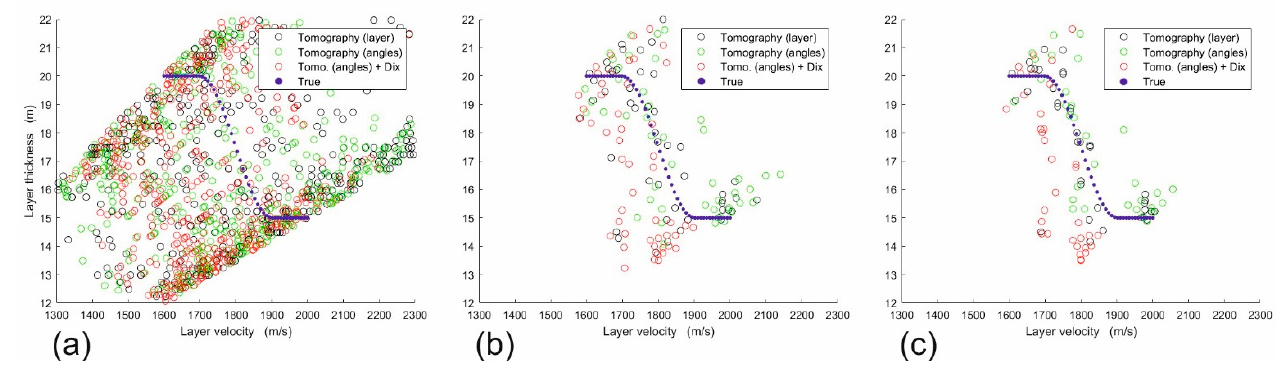
Figure 6. Perturbations of 10 traces using tomography for layer parameters (black circles), angles (green circles) and with a Dix post-processing (red circles). The maximum error percentage in the travel times is 0.03%: all values ( a ), averaged values at each trace ( b ) and median filtering of the averaged points ( c ).